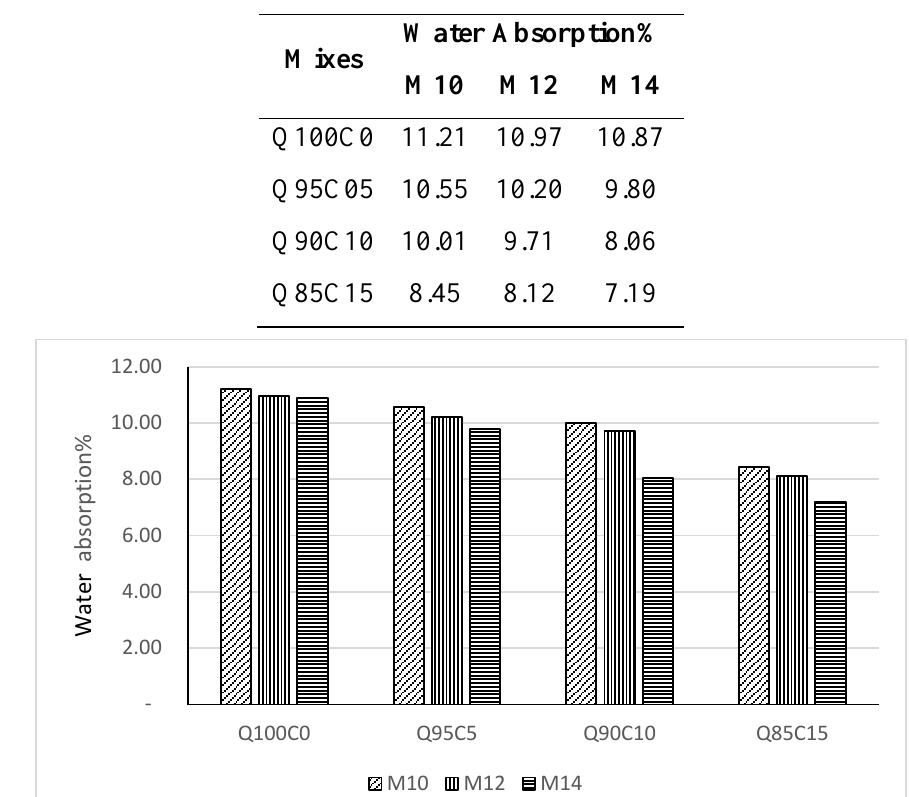
Table 5. Effect of OPC replacement and NaOH concentration variation on water absorption of quartz stone powder- based mortar.